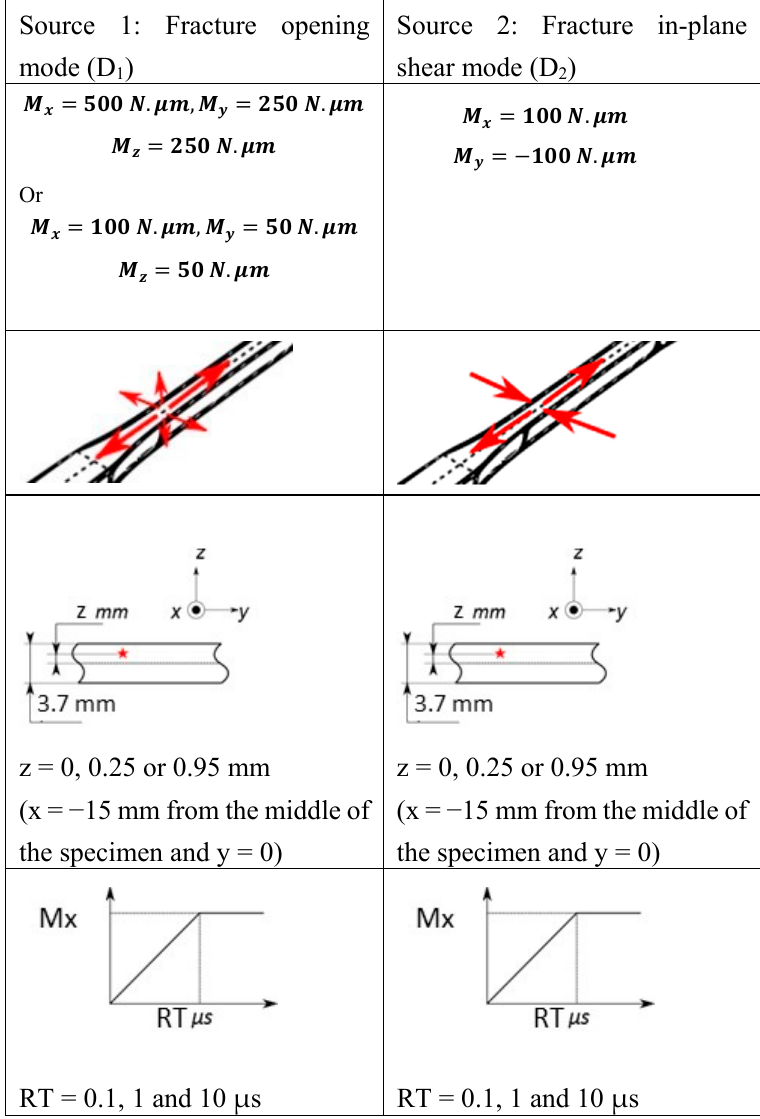
Figure 4. The modelled sources: fracture opening mode (D 1 ) and fracture in-plane shear mode (D 2 ) (values of the applied loading M α are indicated for each source. The values of the source rise time and of the location d of the source are also pictorially represented).